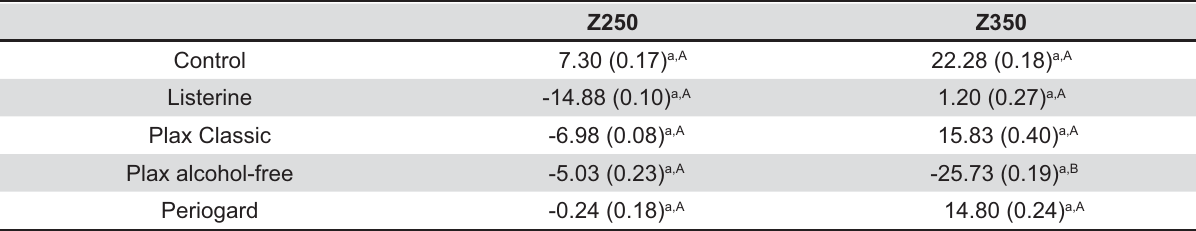
Table 3- (cid:21)j(cid:17)(cid:5)(cid:20)%(cid:21)(cid:31)%"(cid:5)(cid:20)(cid:22)(cid:5)(cid:18)(cid:22)(cid:21)(cid:22)(cid:17)K(cid:19)(cid:5)"(cid:19)(cid:24)(cid:20)%(cid:4)(cid:21)>(cid:24)(cid:18)(cid:21)(cid:132)(cid:20)(cid:24)(cid:24)(cid:25)(cid:21)(cid:29)(cid:19)(cid:16)(cid:18)(cid:24)#(cid:5)(cid:18)(cid:22)(cid:20)(cid:17)%%(cid:21)(cid:31)(cid:9)(cid:4)(cid:21)K(cid:5)(cid:14)(cid:28)(cid:17)%(cid:21)(cid:31)!H&(cid:5)(cid:15)(cid:21)|}~(cid:127)|(cid:26)(cid:21)(cid:128)(cid:24)(cid:20)>(cid:17)(cid:18)(cid:18)(cid:24)(cid:20)(cid:19)(cid:129)%(cid:21)"(cid:17)%"(cid:130)(cid:21)(cid:25)(cid:131)(cid:8)(cid:12)(cid:8)(cid:10)(cid:4)